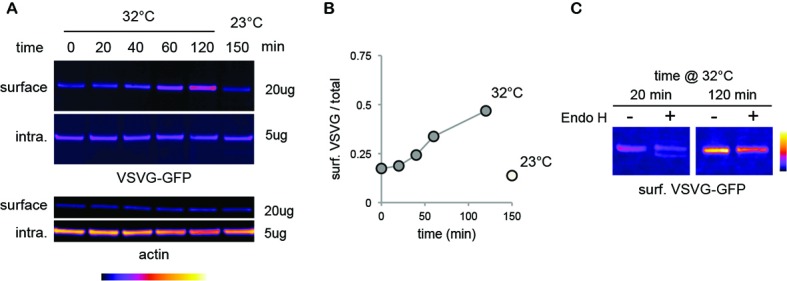
Standard mature surface N-glycans are typically insensitive to EndoH.9AB) Immunoblots (A) and relative surface expression (B, surface / total protein) of thermosensitive vesicular stomatitis virus glycoprotein (VSVG-GFP) (Presley et al., 1997) in COS 7 cells at various times after release (39–32°C shift) of a temperature-dependent blockade of VSVG exit from the endoplasmic reticulum. Note the progressive accumulation of VSVG at the cell surface at permissive temperature (32°C), but not after a temperature-dependent blockade (23°C)[(Matlin and Simons, 1983)] of post-Golgi transport. (C) Contrasting sensitivity to EndoH of surface VSVG at an early (20 min) or later (120 min) phase after ER-exit release. Note the complete lack of sensitivity of VSVG as mature proteins accumulate at the cell-surface.